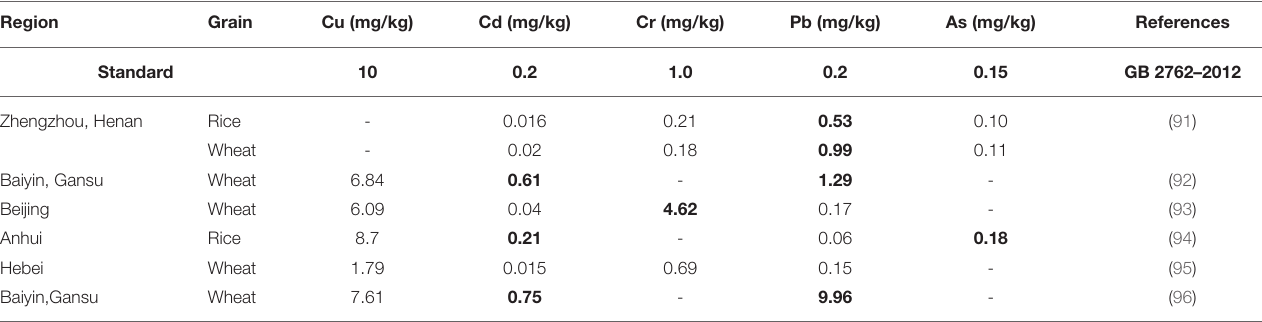
TABLE 4 | The heavy metal/metalloid concentration in some sewage irrigated areas (mg/kg).